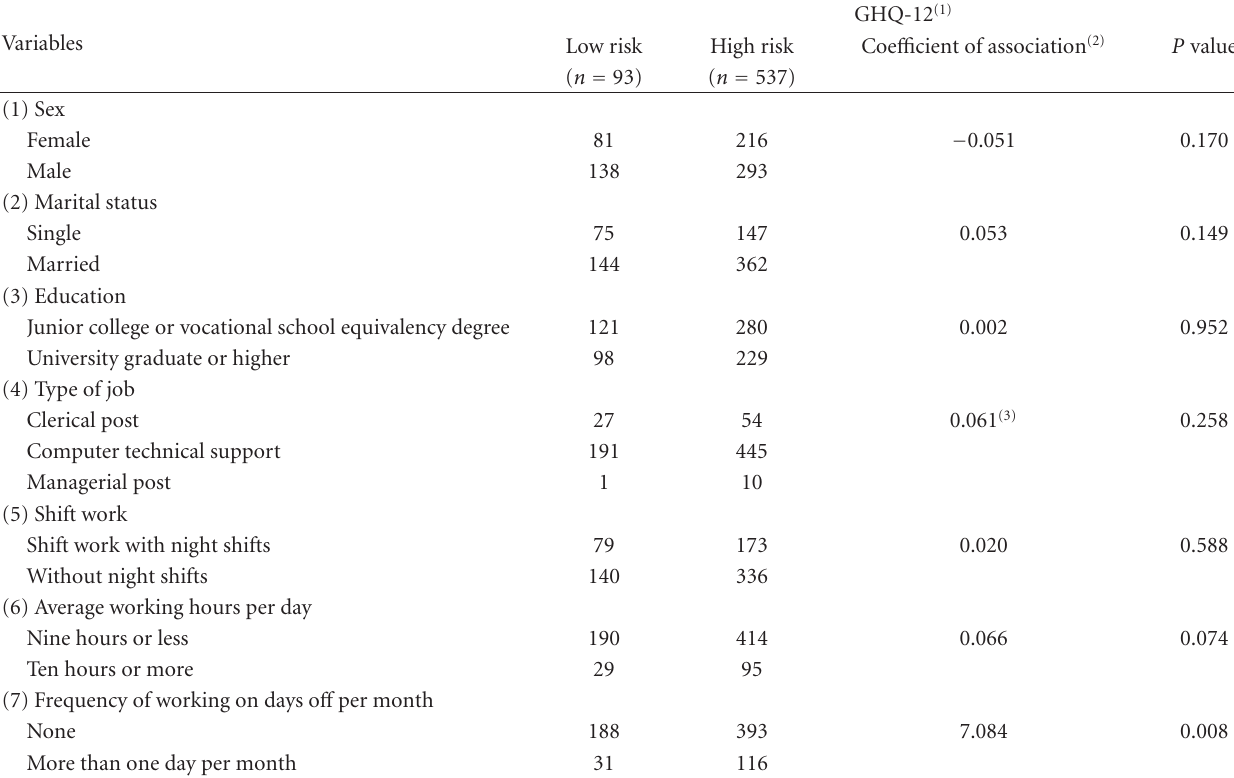
Table 3: Results of coe ffi cient of association between each control variables and GHQ-12 ( N = 728).